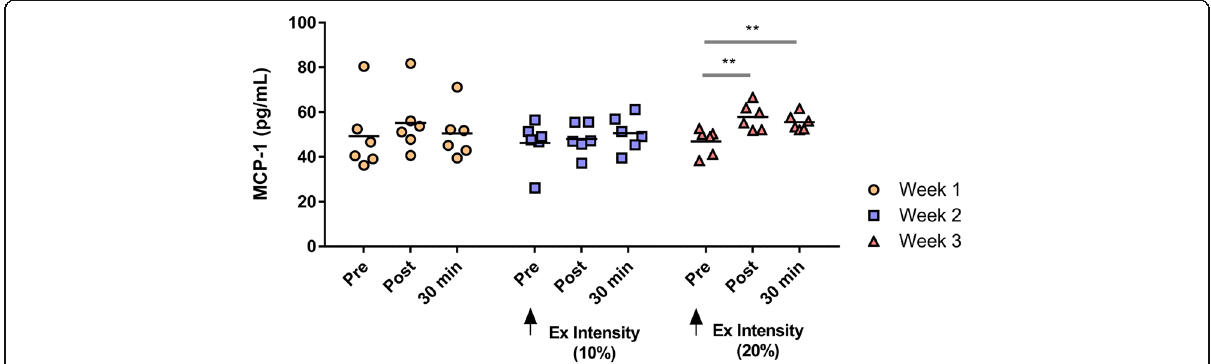
Fig. 7 Plasma [MCP-1] during 3 weeks of exercise training ( N = 6). Significant main effects of time ( P = 0.0003) and interaction ( P = 0.05) were detected. Post hoc Tukey ’ s multiple testing showed significant differences in week 3, between Pre and Post ( P < 0.01) and between Pre and 30 min ( P < 0.01). ** P < 0.01. No significant main effect of intensity was observed ( P >